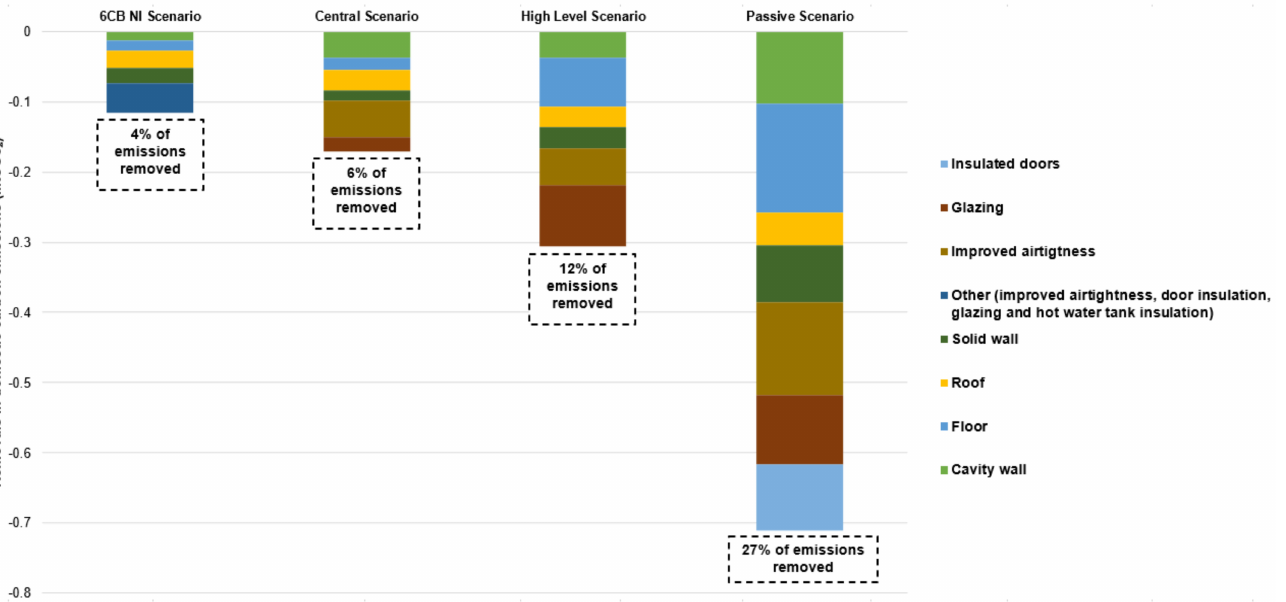
Figure 7. Removal of emissions per measure across all scenarios compared with those of the 6CB NI Central